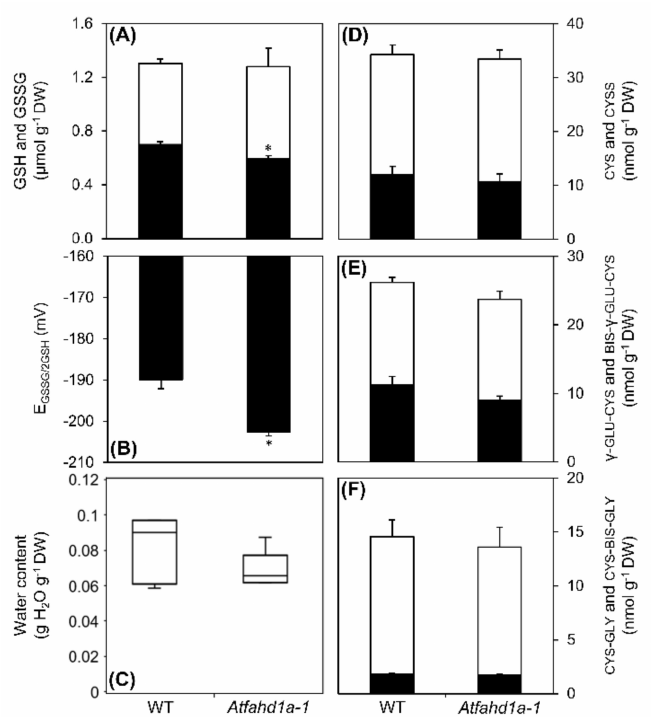
Figure 7. Changes in the concentrations of low-molecular-weight thiols (white bars) and correspond- ing disulphides (black bars) in wild type seeds (WT, ecotype Columbia-0 [Col-0]) and Atfahd1a-1 (fumarylacetoacetate hydrolase domain-containing protein 1) T-DNA insertional mutant seeds in the Col-0 background. ( A ) Glutathione (GSH) and glutathione disulphide (GSSG). ( B ) Half-cell reduction potential of the GSSG/2GSH redox couple (E GSSG/2GSH ) calculated using molar concen- trations, which were estimated through the seed water contents shown in ( C ). ( C ) Water contents of dry seeds equilibrated to 36-38% RH, prior to the analytical measurements shown in the other panels. ( D ) CYSTEINE ( CYS ) and CYSTINE ( CYSS ). ( E ) γ - L - GLUTAMYL - CYSTEINE ( γ - GLU - CYS ) and BIS - γ - GLUTAMYL - CYSTINE ( BIS - γ - GLU - CYS ). ( F ) CYSTEINYL - GLYCINE ( CYS - GLY ) and CYSTINYL - BIS - GLYCINE ( CYS - BIS - GLY ). Data refer to seeds pooled from individual plants of the first generation for each line and are means ± SE ( n = 5 replicates for both lines) with asterisks indicating significant differences ( t -test, p <